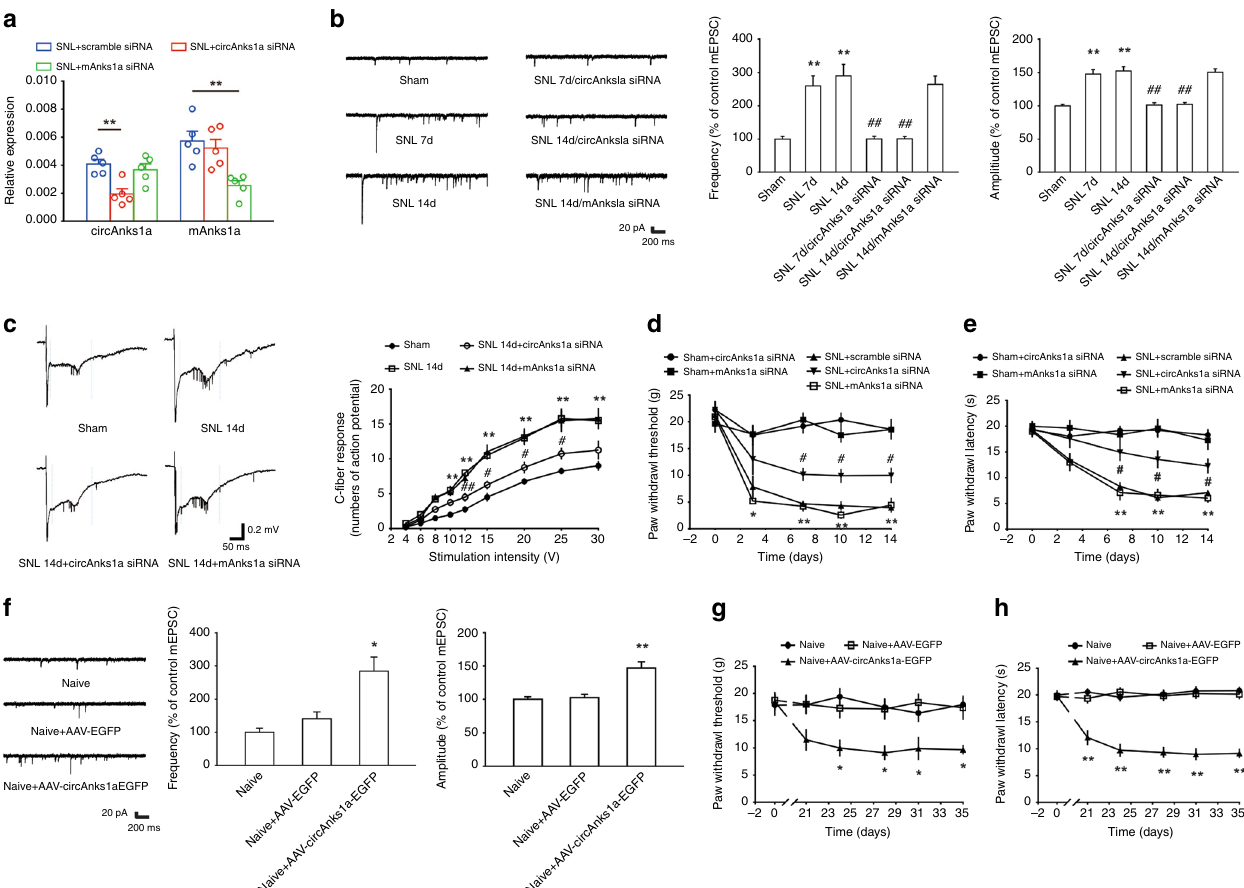
Fig. 3 Upregulation of circAnks1a-mediated neuropathic pain following SNL. a Application of circAnks1a siRNA but not mAnks1a siRNA (1 nmol 10 µ l − 1 i.t. for consecutive 5 days) knocked down the expression of circAnks1a on day 14 following SNL ( ** P < 0.01 vs. the corresponding scramble group,